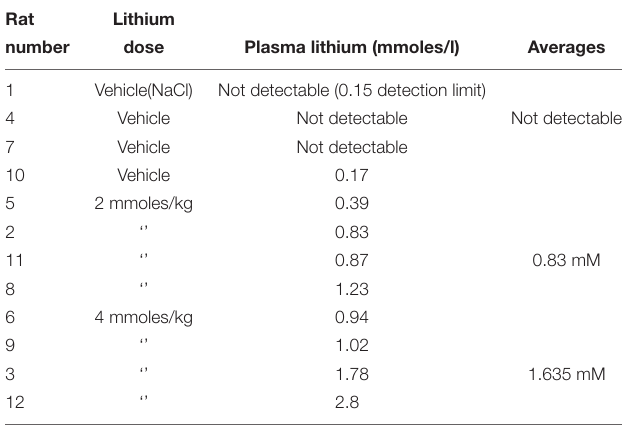
TABLE 6 | Rat plasma lithium levels achieved after a single i.p. dose of lithium